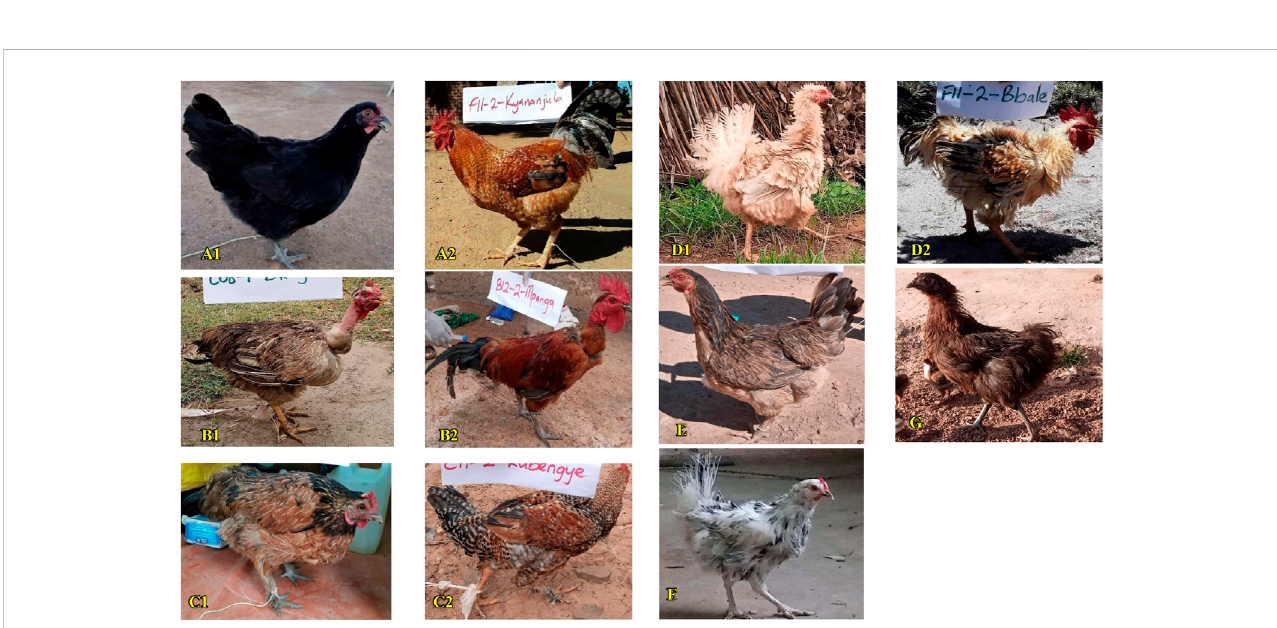
FIGURE 5 Feather distribution and structure in the indigenous chicken population in Uganda. (Al, A2) Normal feather distribution. (Bl, B2) Naked-neck. (Cl, C2) Ptilopody (feathered shanks/tarsus). (Dl, D2) Frizzle feather structure. (E) Smooth/neat plane feather. (F) Silky and (G) super fi cially silky feather